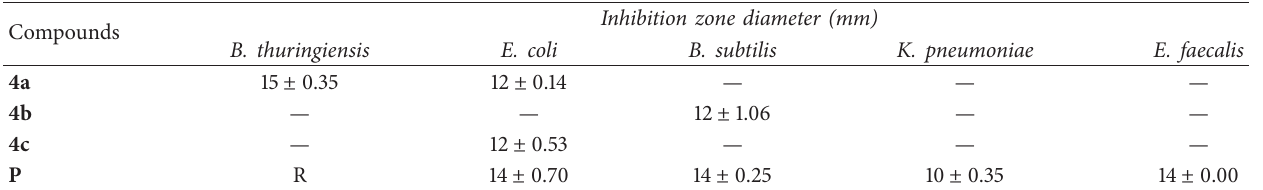
Table 2: Antimicrobial activity of synthesized compounds 4a – c (a,b,c) compared to an antibiotic like penicillin (P). Compounds